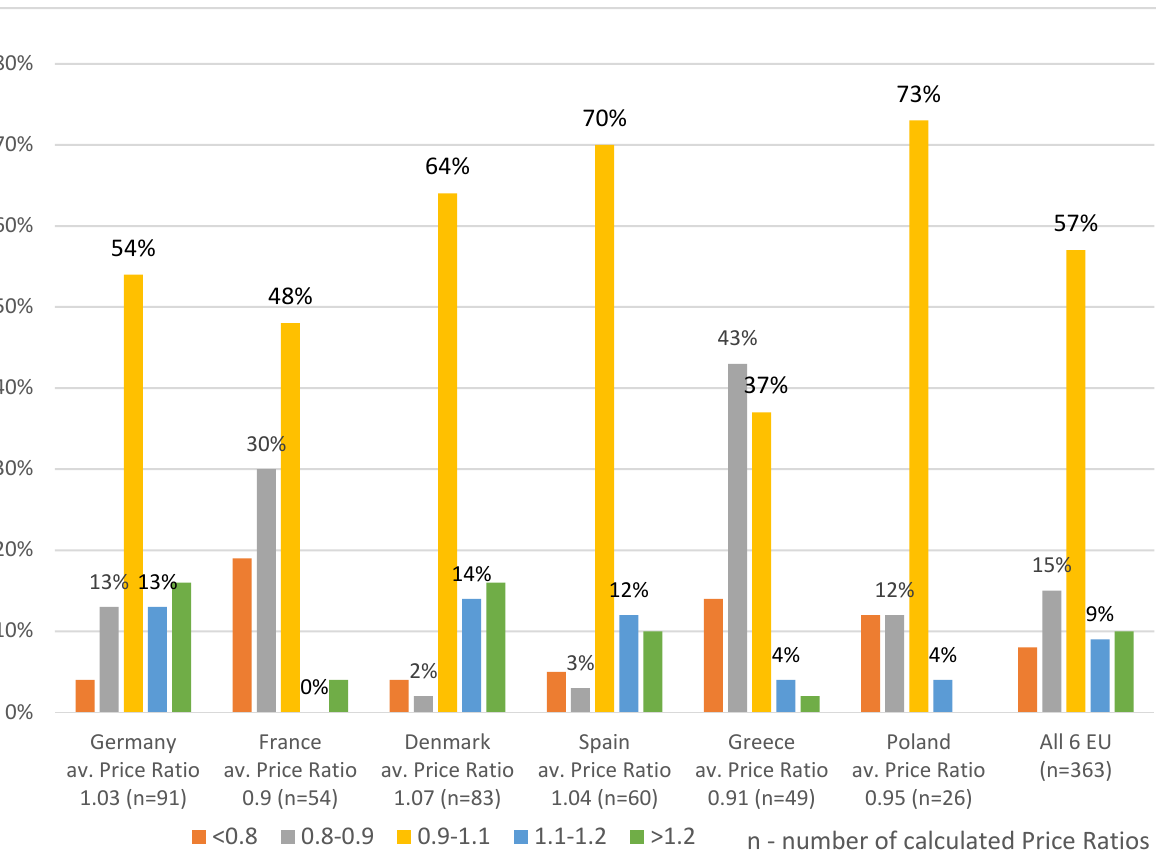
Figure 3. Price Ratios Distribution: Individual EU Country vs. average from six EU Countries (Denmark, France, Germany, Greece, Spain, Poland).